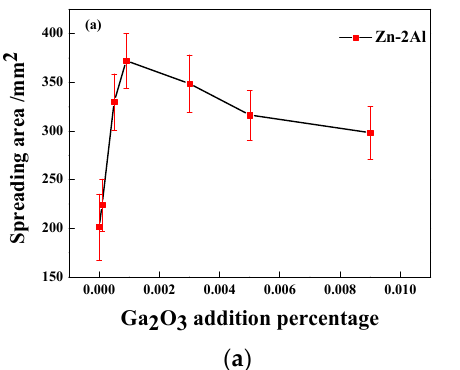
Figure 2. EDX elemental mapping of Ga 2 O 3 particles.